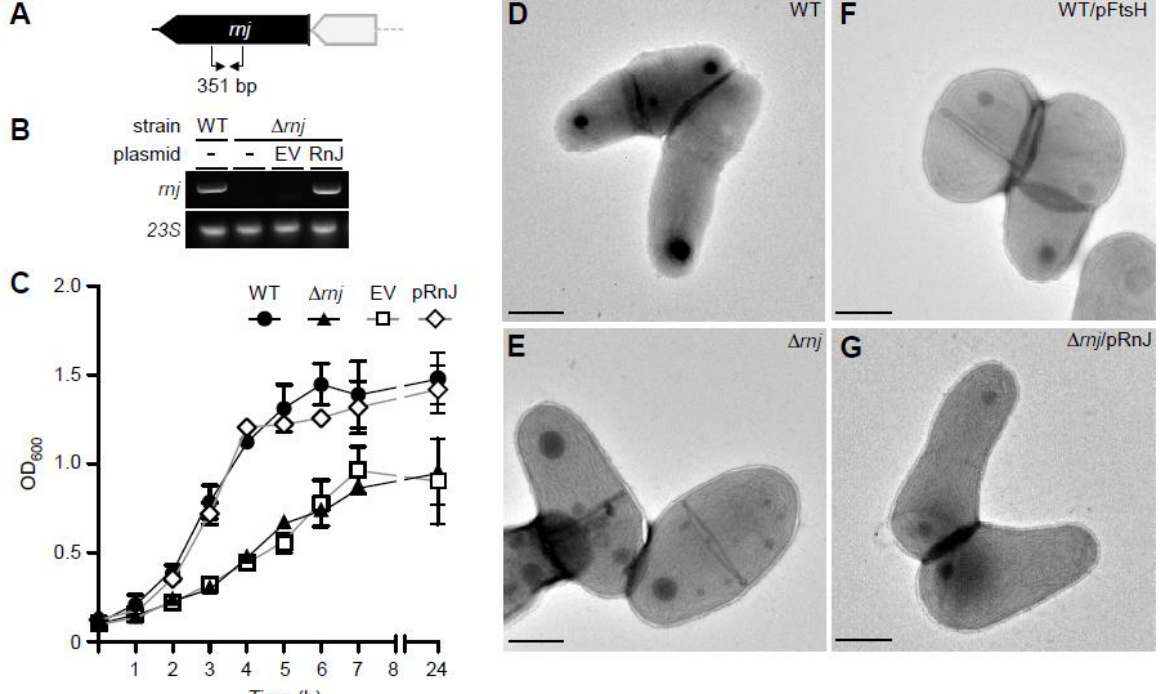
Figure 2. The C. diphtheriae ∆ rnj mutant is defective in cell growth and morphology. ( A , B ) An in-frame, non-polar mutant of rnj was generated. The presence of rnj in the parental, deletion mutant, and complementing strains was determined by RT-PCR using probes (arrows) that detect a 351-bp amplicon; 23S rRNA was used as control. ( C ) Overnight cultures of C. diphtheriae indicated strains grown at 30 ◦ C were used to inoculate fresh cultures, and their growth was monitored by OD 600 . ( D – G ) Log-phase cells were immobilized on nickel grids, stained with 1% uranyl acetate, and viewed by an electron microscope JEOL1400; scale bars indicate 0.5 μm.